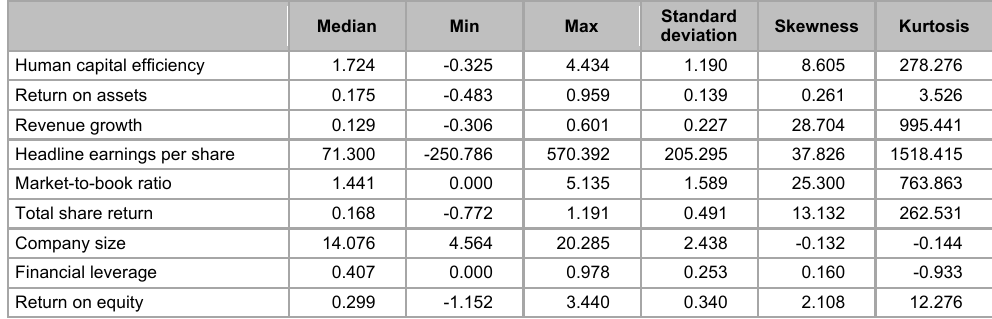
Descriptive statistics of the research population